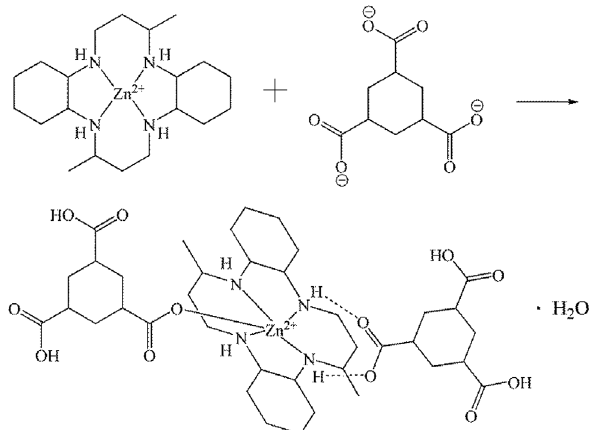
Table 1: Selected bond distances (Å) and angles ( ° ) for